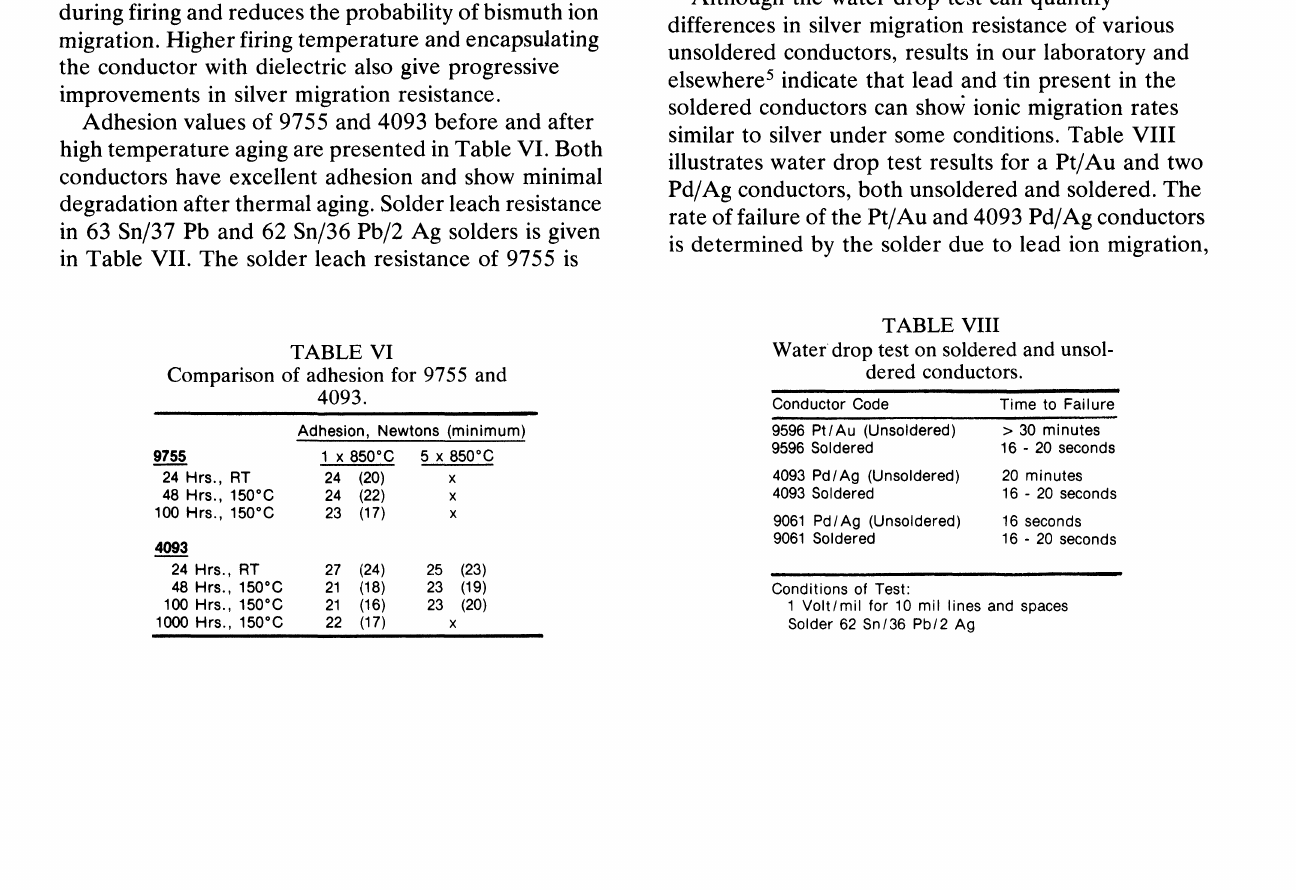
TABLE VIII Water drop test on soldered and unsol- dered